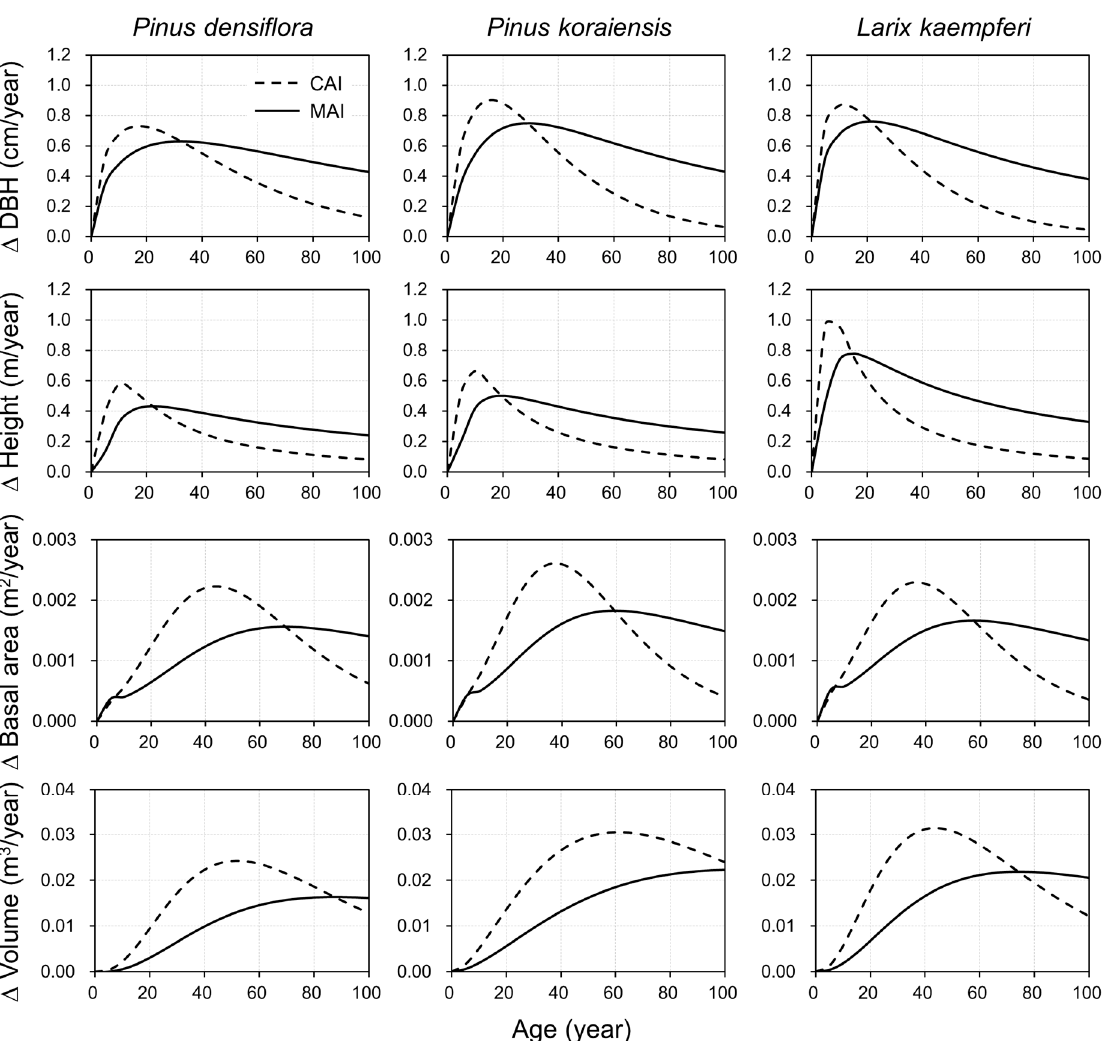
Figure 5. Simulated annual increment by tree size variables and species to examine current annual increment (CAI) and mean annual increment (MAI). The best models by variables are based on fit statistics and model performance of the results; the selected growth functions are Chapman-Richards for DBH and stem volume, Korf for height, and Gompertz for basal area.